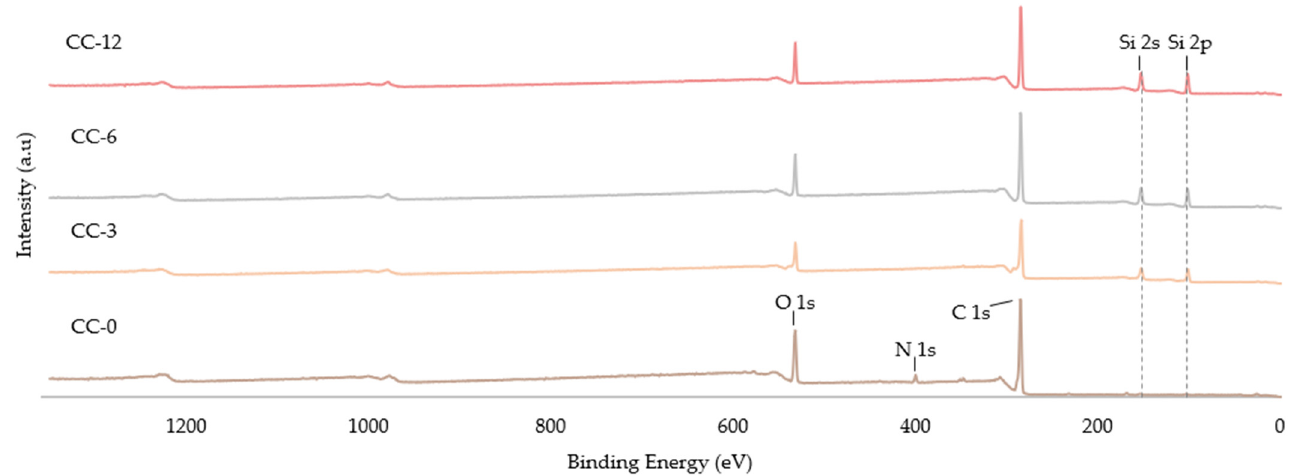
Figure 3. XPS survey of untreated leather and plasma-coated leather samples with HMDSO.